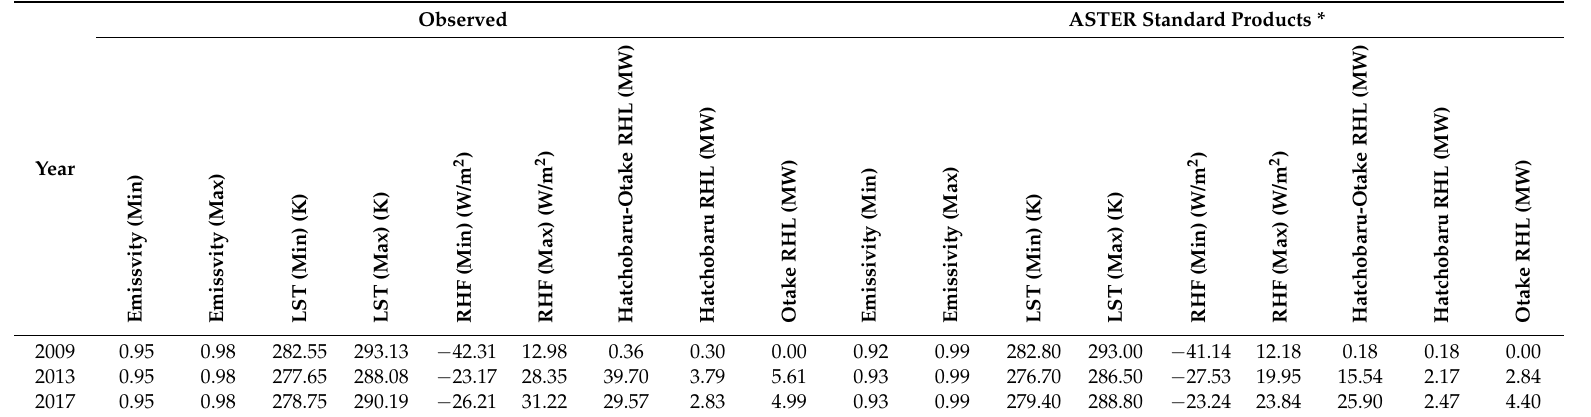
Table 5. Comparison of the observed and ASTER standard products base heat loss from the study